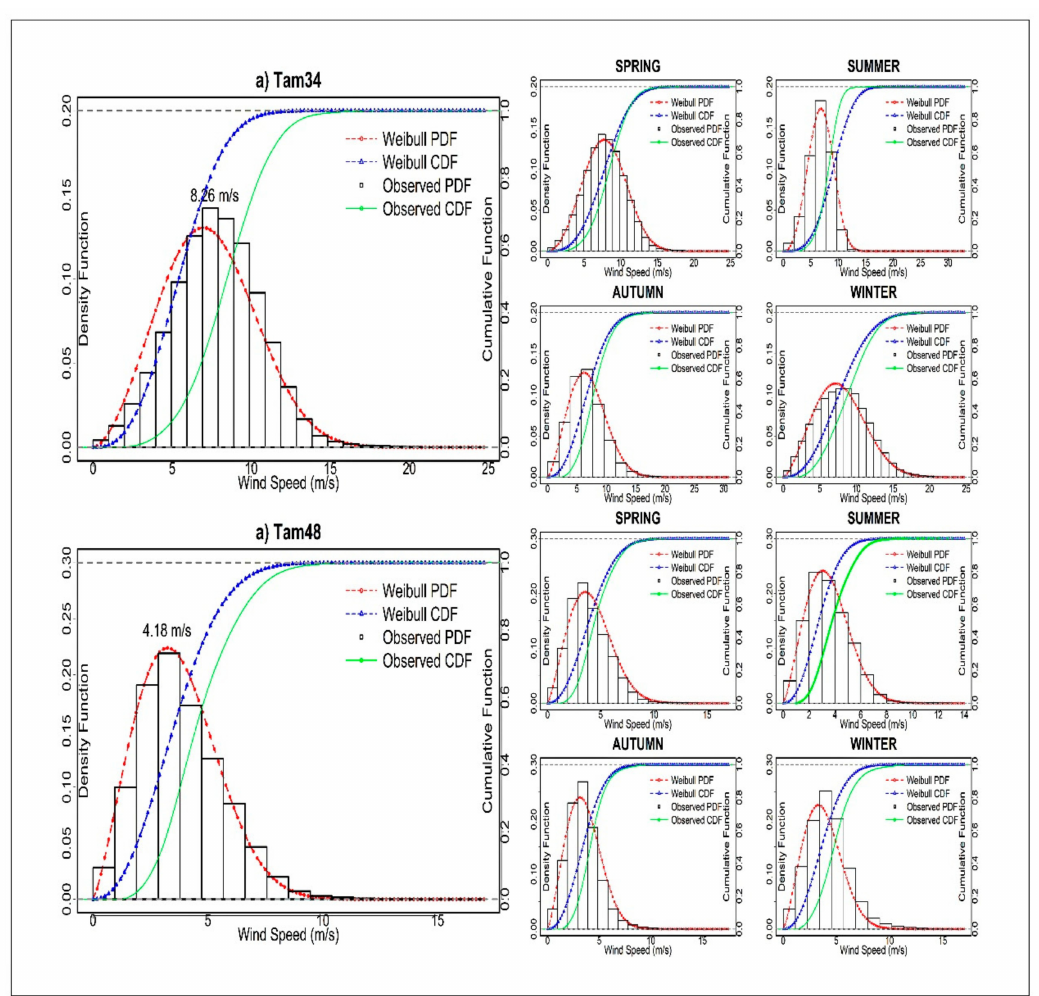
Figure 4. Annual and seasonal Weibull distributions in the state of